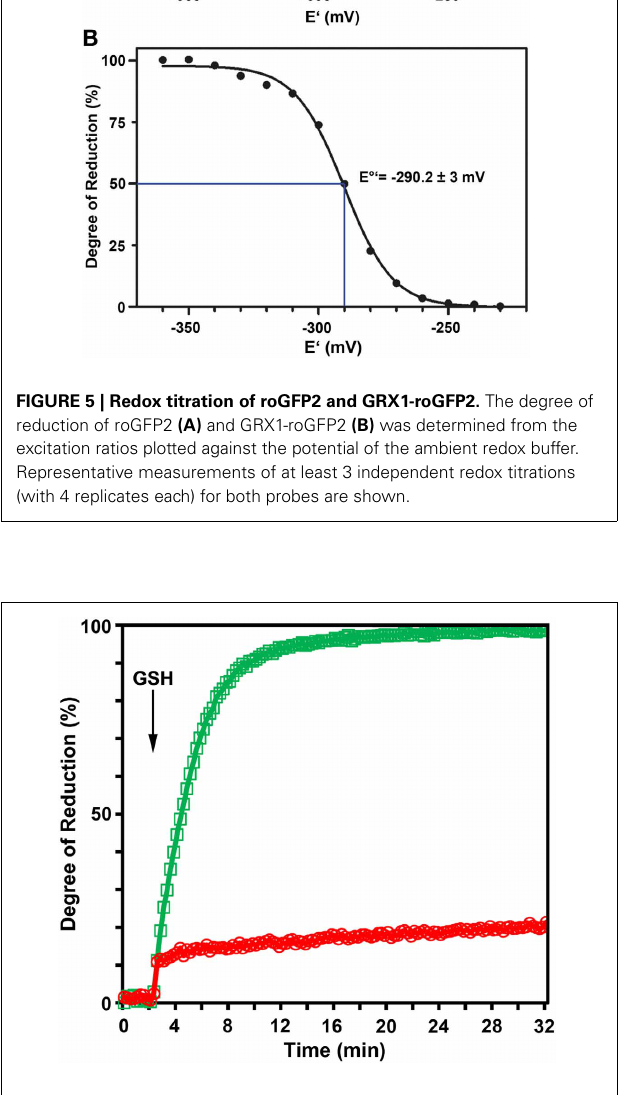
FIGURE 6 | The N-terminally fused glutaredoxin catalyzes the transfer of electrons from glutathione to roGFP2-iL. The excitation ratio 390/480nm with emission at 520nm was followed over time. Fully reduced glutathione was added to a solution of oxidized roGFP2-iL ( ◦ ) or GRX1-roGFP2-iL ( (cid:4) ), respectively 2.5min after the start of the measurement. Change of reduction was recorded over time after injection of 2mM reduced glutathione. The reaction buffer contained 100 μ M NADPH and glutathione reductase at pH 7.4 to maintain full reduction of glutathione over the measured time ( n = 4).